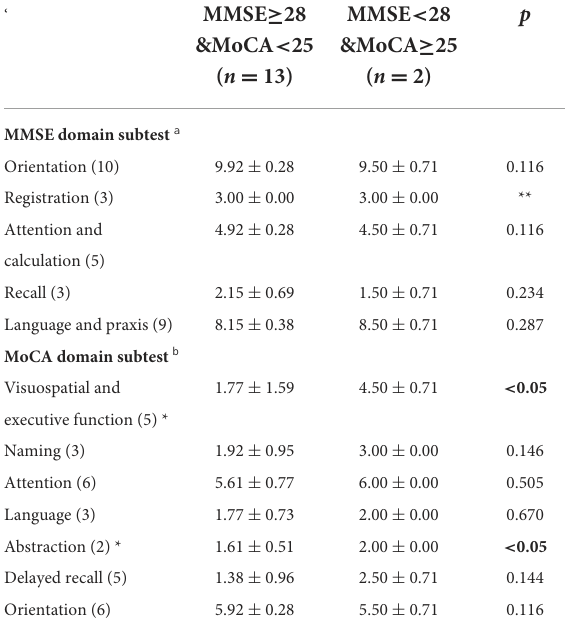
TABLE 4 Comparisons of Proportions of MoCA and MMSE domain subtest below full scores.